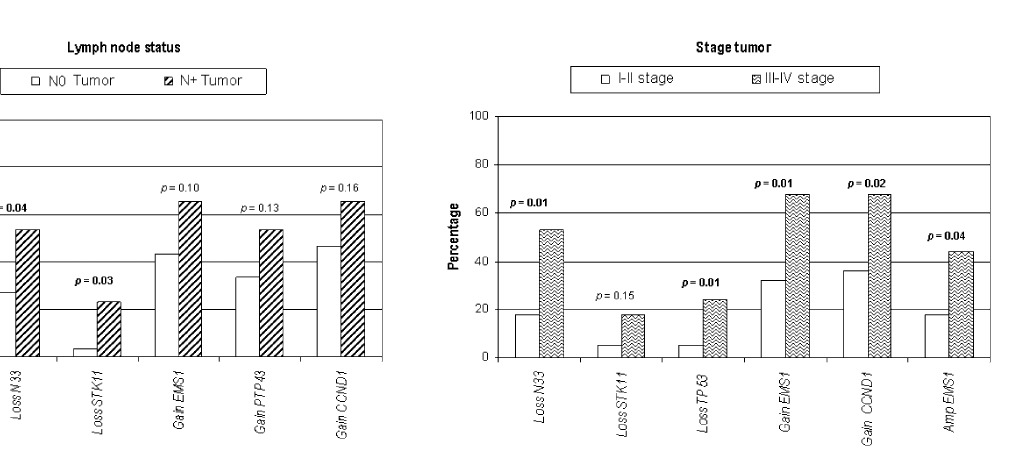
Fig. 2. Genetic alterations associated to lymph node positive larynx and pharynx tumors detected by MLPA. p = 0 . 001) but not to pharyngeal N + tumors (1 / 8 N 0 tumors versus 2 / 14 N + tumors; Fisher exact, p = 0 . 7).